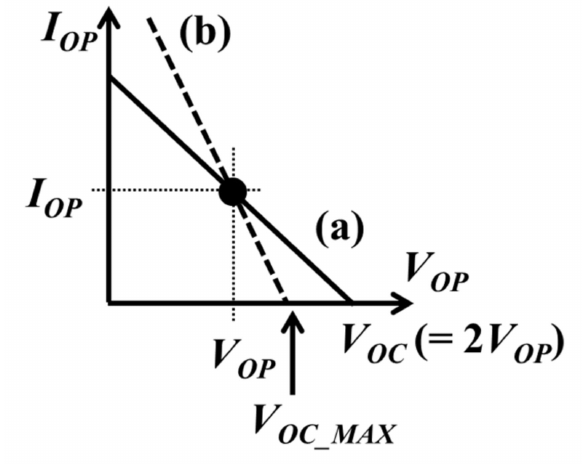
Figure 9. Operating point of TEG/Conv. vs. V OC depending on V OC_MAX